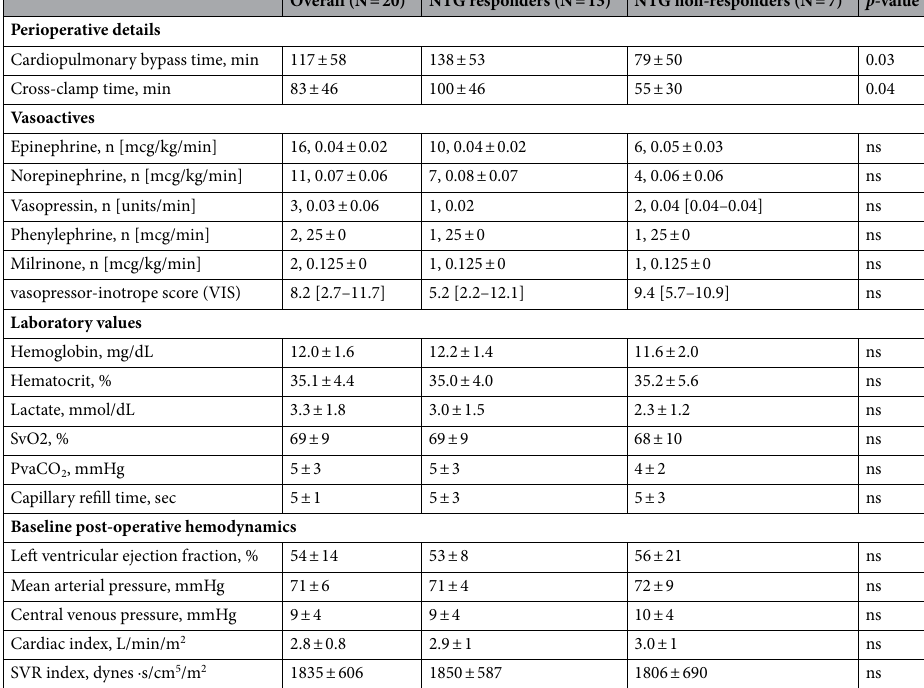
Table 2. Clinical variables of participants and by nitroglycerin responsiveness. Mean ± SD, Median [IQR].